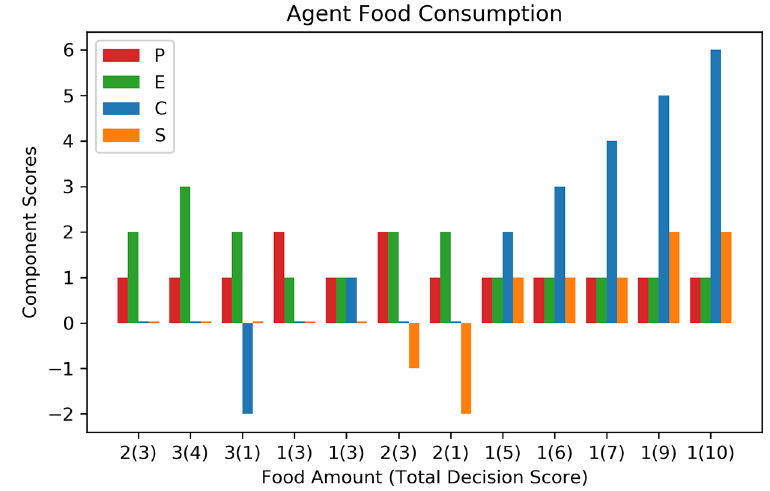
Figure 3. The complete food consumption history of an agent with respective